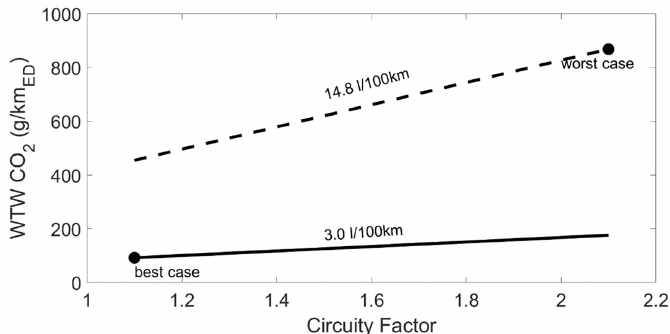
Figure 6. Equivalent WTW emissions of CO 2 of the Prius as a function of circuity factor, traffic con- ditions, and driving style.